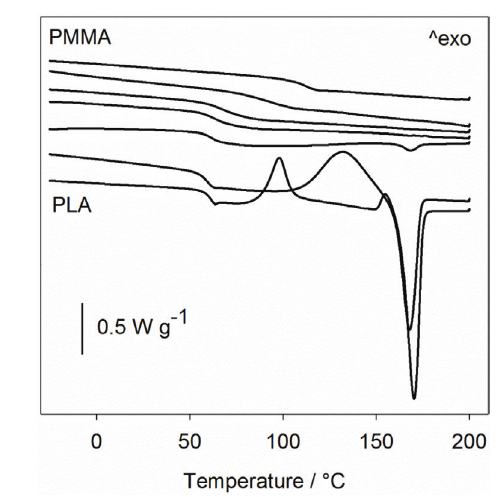
Fig. 7 – DSC second heating scan of PLLA, PMMA, and PLLA/PMMA blends recorded at 10 °C min –1